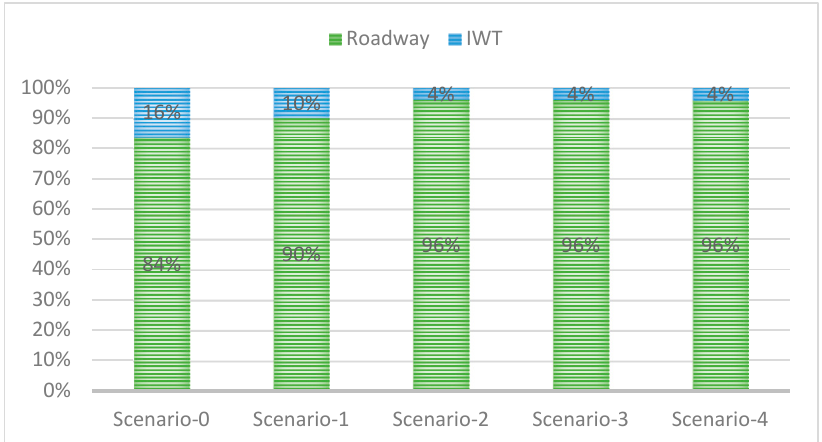
Figure 15. Proportion of transport modes from crossdocking center to retailer store.